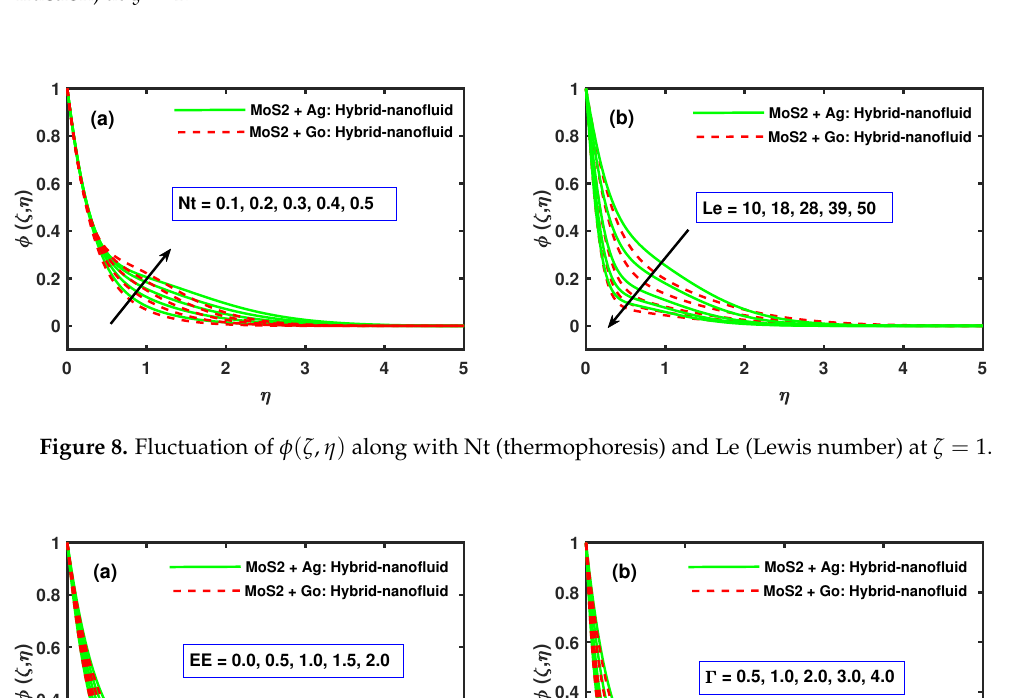
Figure 7. Fluctuation of θ ( ζ , η ) along with S f (shape factor parameter) and Φ 2 (nanoparticles volume fraction) at ζ = 1.